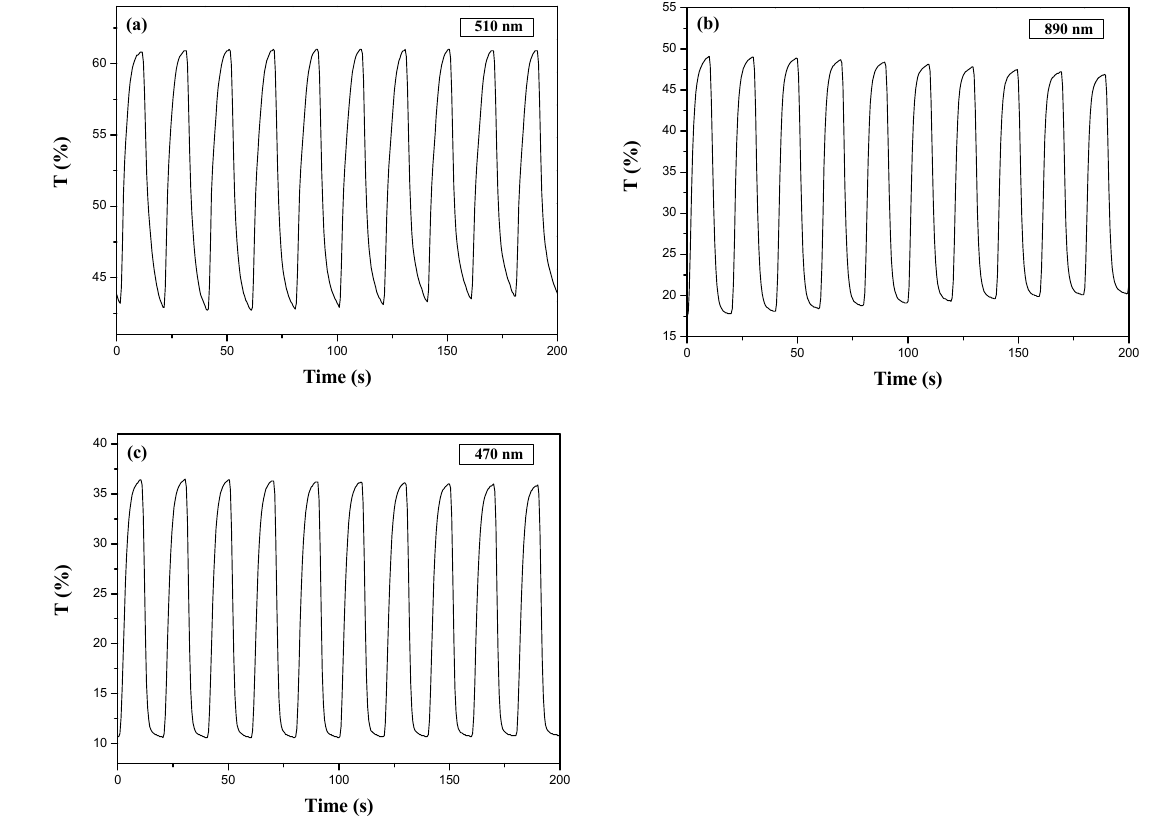
Figure 8. Transmittance variations of ( a ) PInc, ( b ) P(Inc- co -bT), and ( c ) PbT electrodes in PC+ACN solution containing 0.2 M LiClO 4 between 0.0 V and +0.8 V with a residence time of 10 s. Table 2. Optical and electrochemical properties investigated at the selected applied wavelength for the electrodes. Polymer